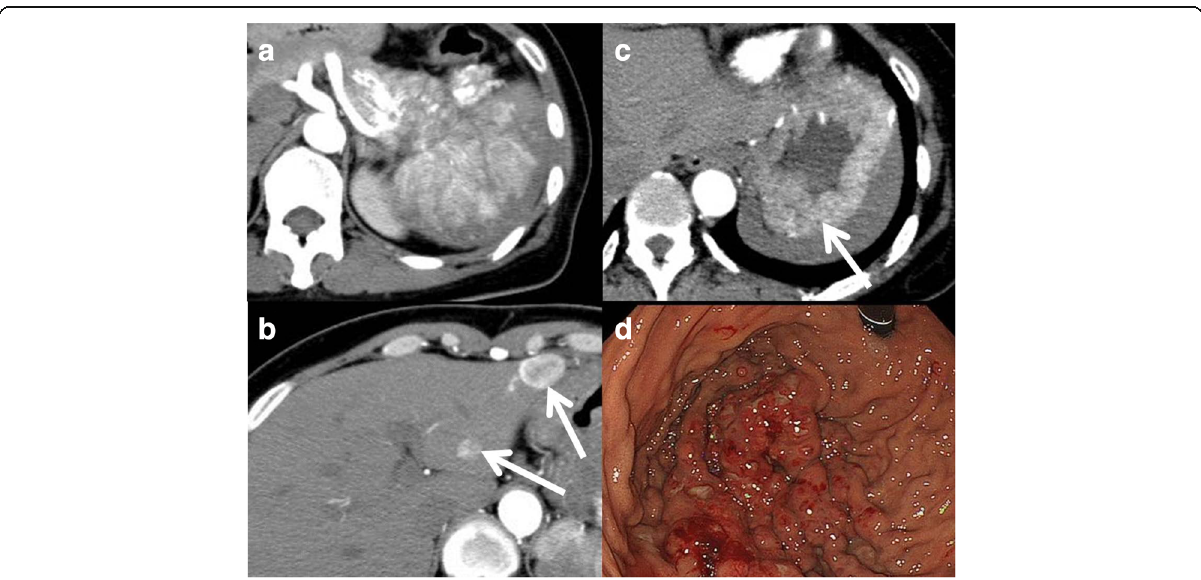
Fig. 1 Abdominal contrast-enhanced CT findings and upper endoscopy findings. CT showing a hypervascular tumour in the tail of the pancreas, infiltrating the spleen and the splenic vein ( a ). Multiple hypervascular tumours in the liver ( b ). Hypervascular tumour in the upper part of the stomach ( c ). Upper endoscopy showing a big tumefactive lesion in the fornix and greater curvature ( d